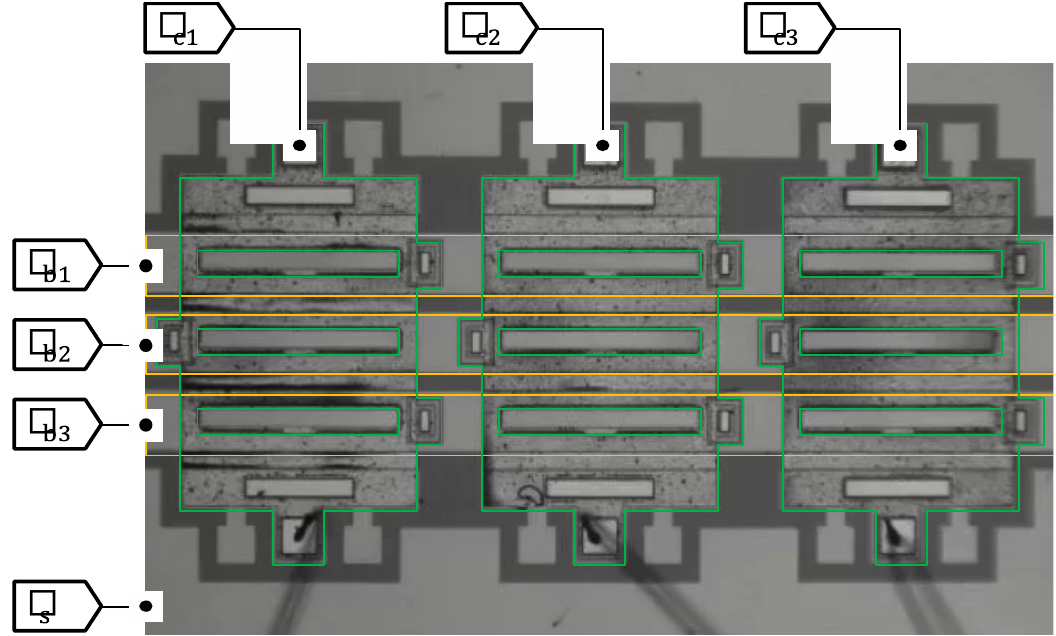
Figure 8. Electrical interconnection of the 3 × 3 micro shutter array. The shutter blades are connected in the lateral direction to form three rows, while the cover plates form three columns. The substrate is used as a common electrode.